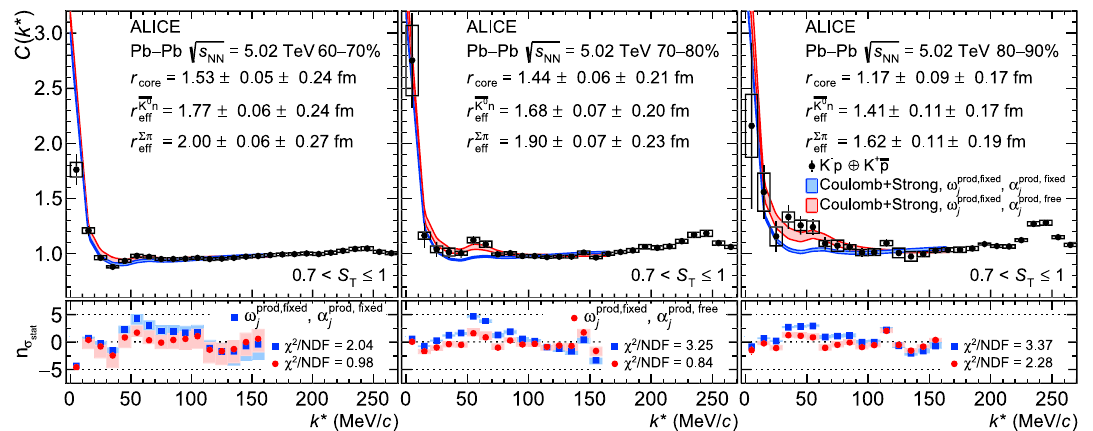
Fig. 6 (K − p ⊕ K + p) correlation functions obtained in Pb–Pb colli- √ s NN = 5 . 02 TeV in the 60–70% (left), 70–80% (middle) and sions at 80–90% (right) centrality intervals. The measurement is shown by the black markers, the vertical error bars and the boxes represent the statis- tical and systematic uncertainties respectively. The red and blue bands